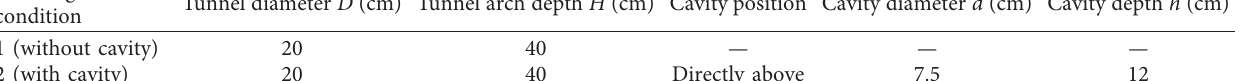
Table 2: Model test plan design.